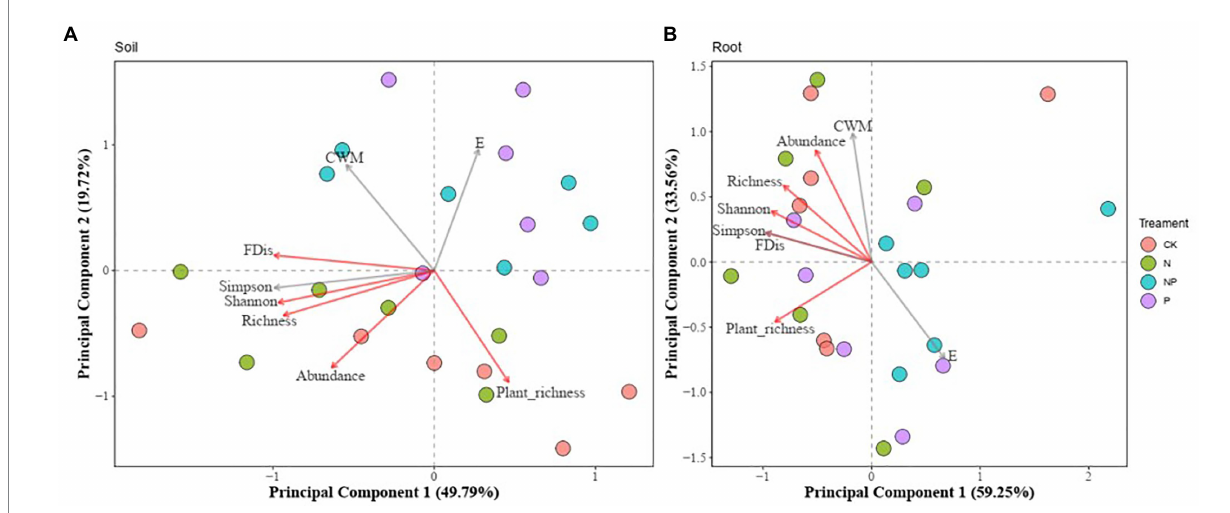
FIGURE 1 Principal component analysis (PCA). Relationship between soil nematode diversity and soil physicochemical properties (A) and plant root functional traits (B) under fertilization treatments. CWM, community means based on nematode body size; FDis, Functional dispersion index; Abundance,